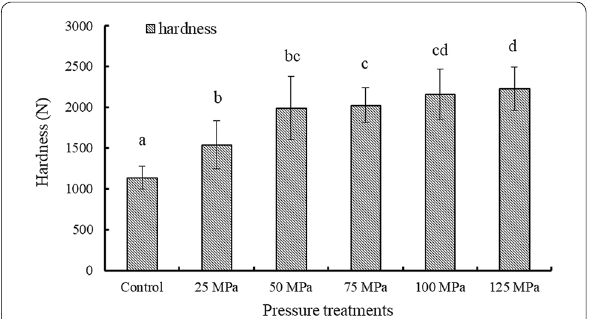
Fig. 6 Average hardness of specimens which were control (0.1 MPa),